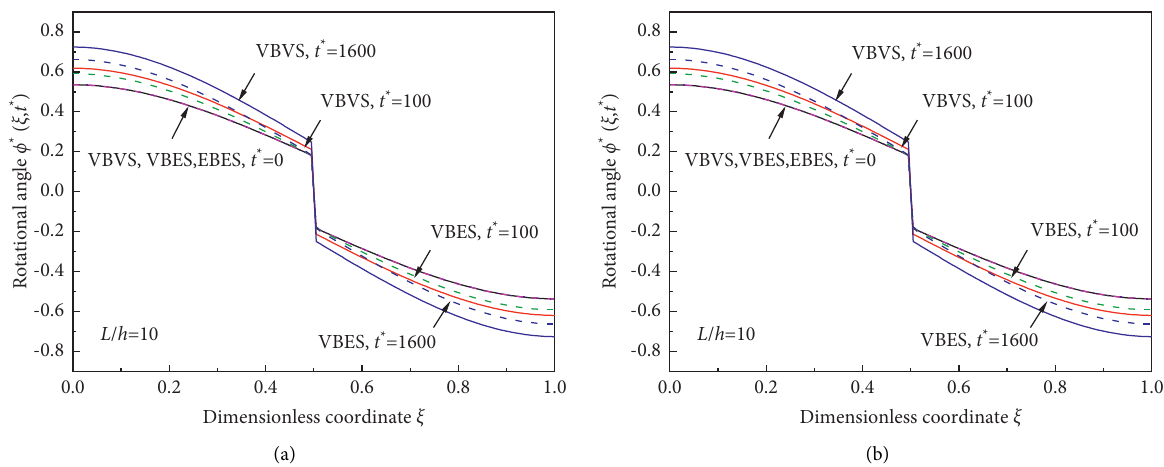
Figure 8: (a) Distribution of dimensionless deflection w ∗ ( ξ , t ∗ ) versus dimensionless coordinate ξ of the viscoelastic cracked beam with different cracked beam models. (b) Distribution of dimensionless rotational angle φ ∗ ( ξ , t ∗ ) versus dimensionless coordinate ξ of the viscoelastic cracked beam with different cracked beam